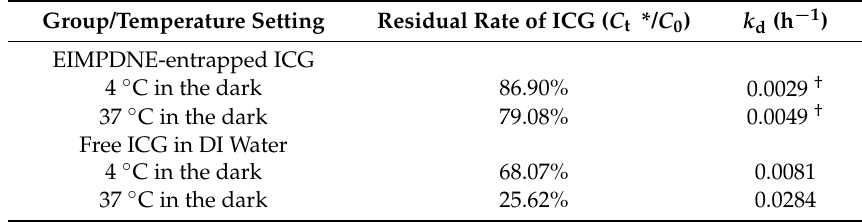
Table 1. Analyses of residual percentages and degradation rate coefficients of the EIMPDNE-entrapped ICG and freely-dissolved ICG after a 48 h